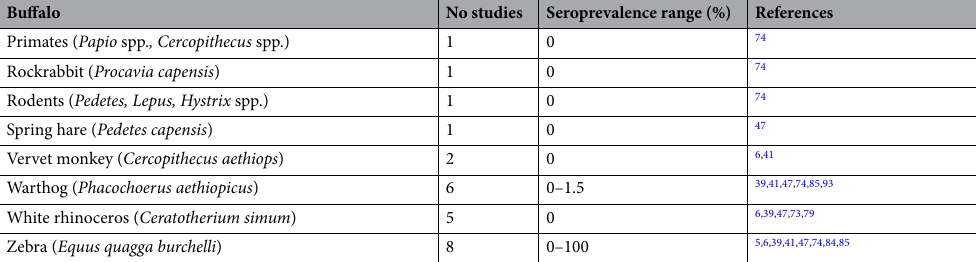
Table 4. Range of results for serological prevalence of Brucella spp. in African wildlife by species arranged in groups: buffalo, antelope, carnivores and all other species.